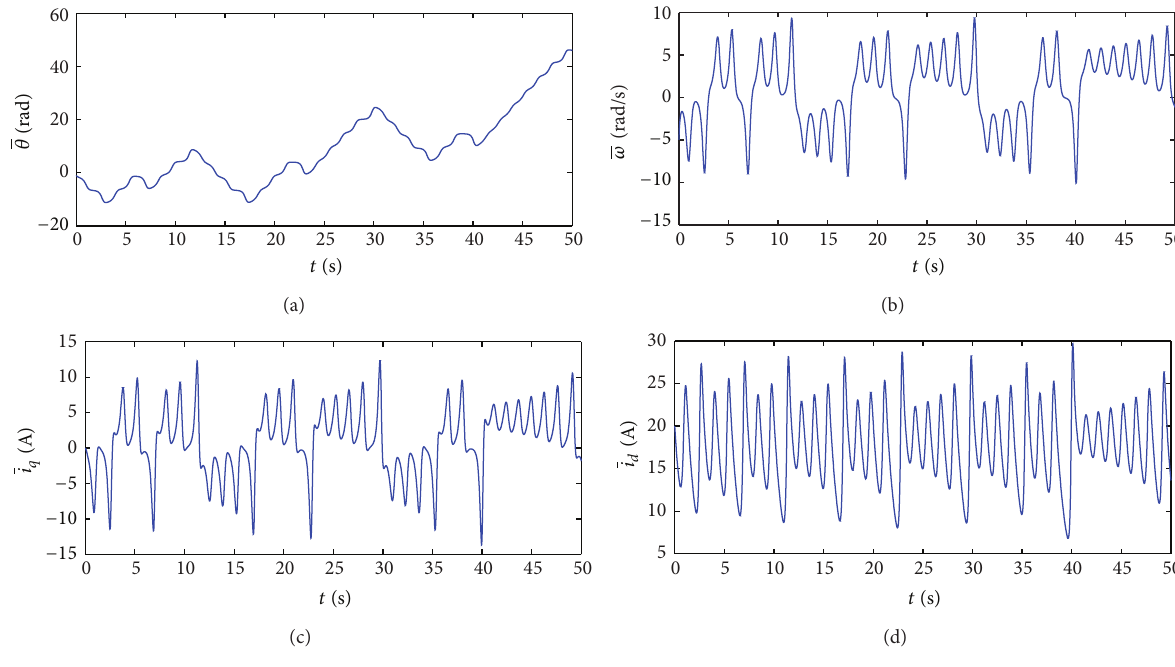
Figure 3: The chaotic time series of PMSM.